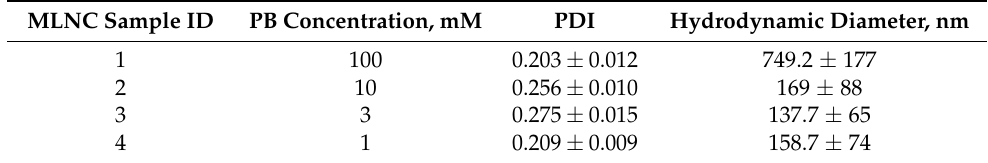
Table 2. Physicochemical characteristics of the core nanoparticles in phosphate buffer containing different magnesium salts.